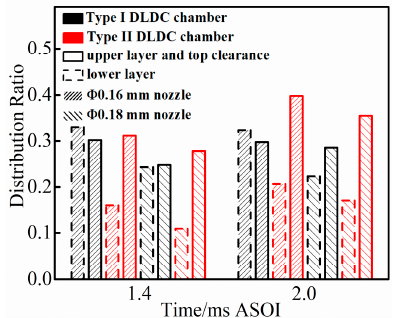
Figure 16. The fuel spray distribution ratios at different times with medium load, different nozzles, 150 MPa injection pressure and 5 °CA BTDC injection timing of Mode B.